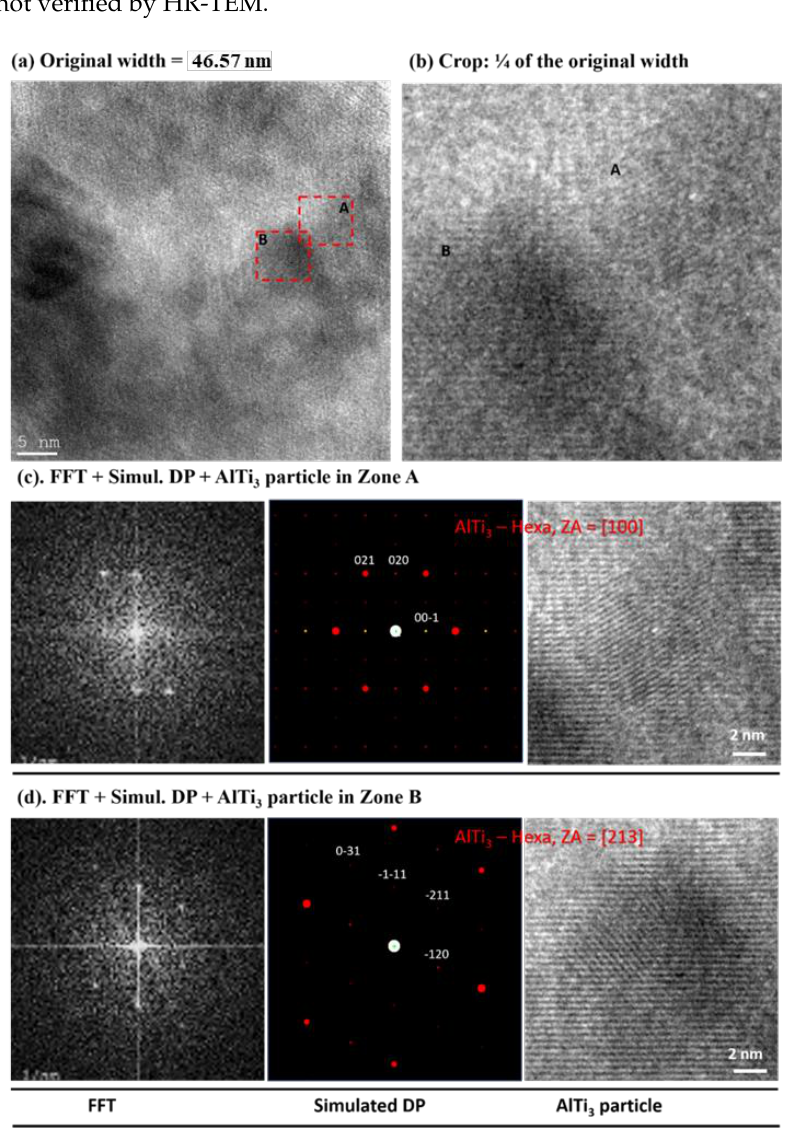
Figure 2. HR-TEM characterization of AlTi 3 nanoparticles in NaH + 3TiCl 3 ∙ AlCl 3 material after washing: ( a ) Bright field TEM image captured with original width; ( b ) Bright field TEM image cropped ¼ of the original width; ( c ) FFT + simul. DP + particle in zone A; and ( d ) FFT + simul. DP + particle in zone B. FFT was calculated in each region and compared with simulated diffraction patterns (DPs) in the adequate orientation; the width of the FFT and corresponding simulations are 18 nm − 1 .